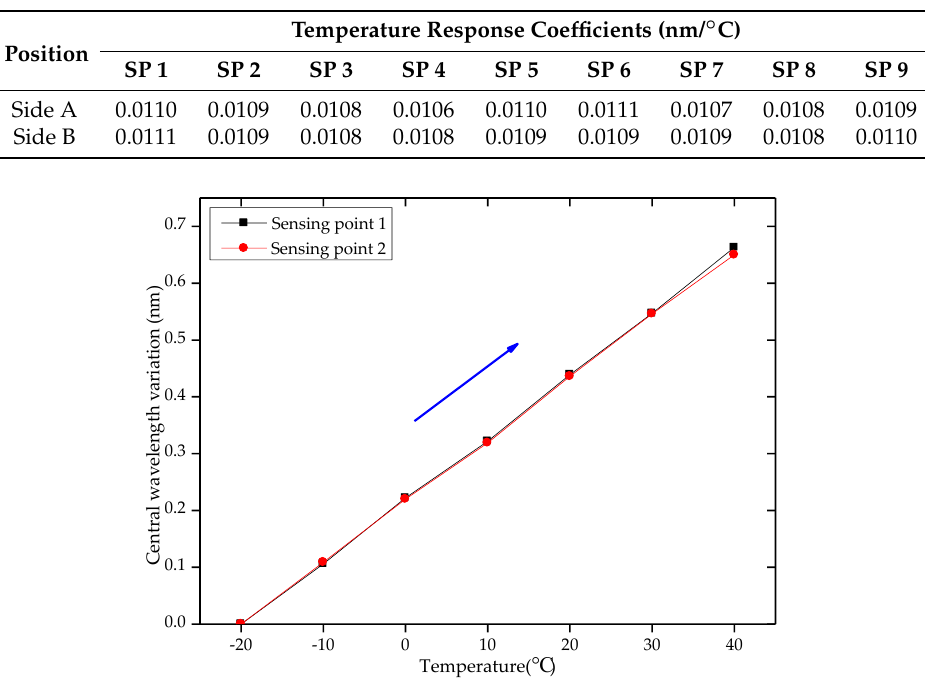
Table 2. Temperature response coefficients at each sensing point (SP).